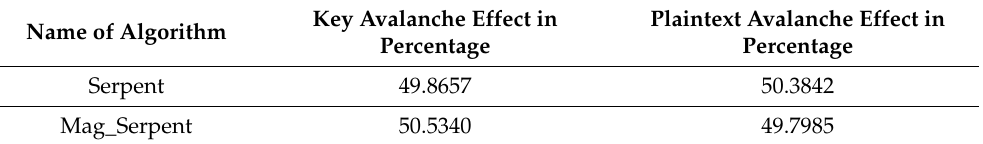
Figure 14. Experimental plaintext Avalanche Effect in percentage. Table 21. Avalanche Effect of key and plaintext when one bit was